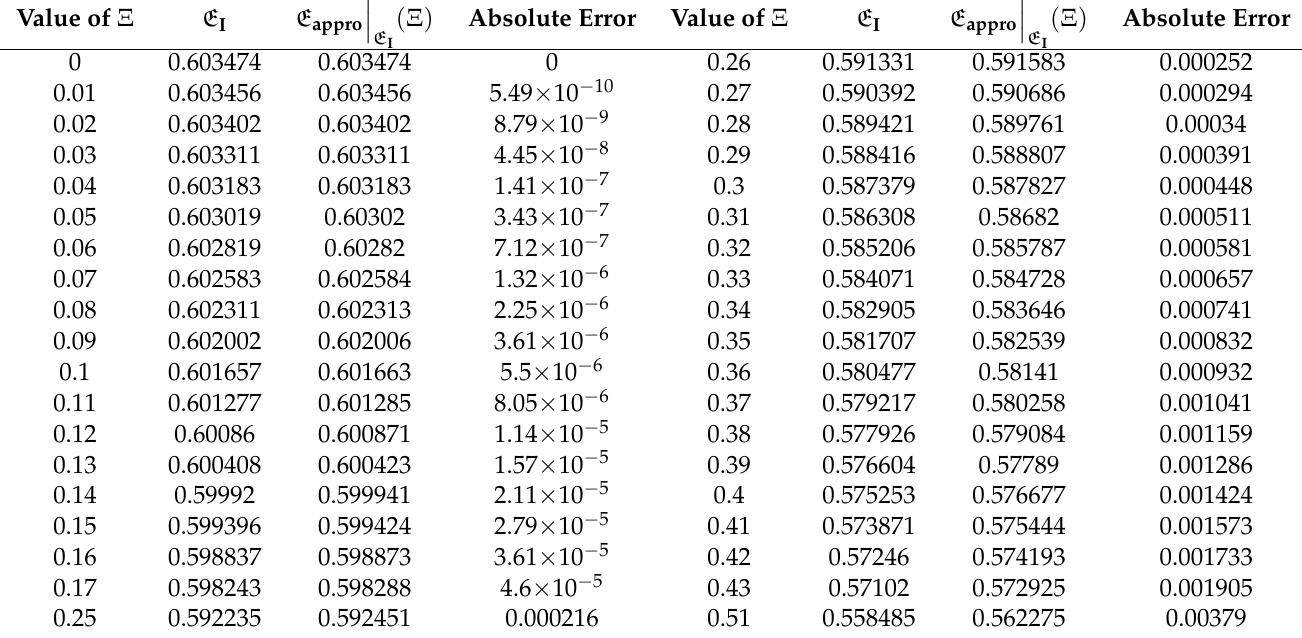
Table 2. Accuracy of the MKud method’s solutions through AD